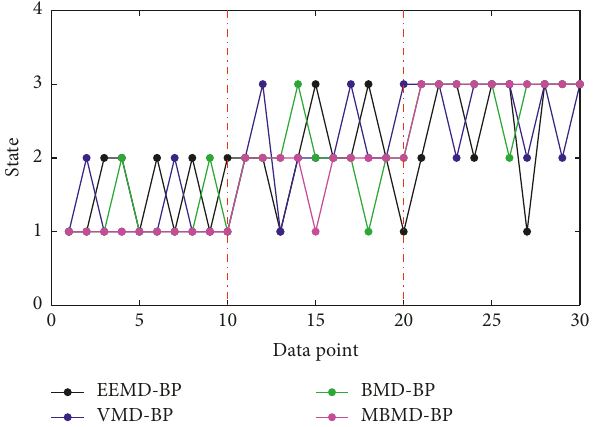
Figure 21: Fault identification diagram of low-speed hub bearing of the